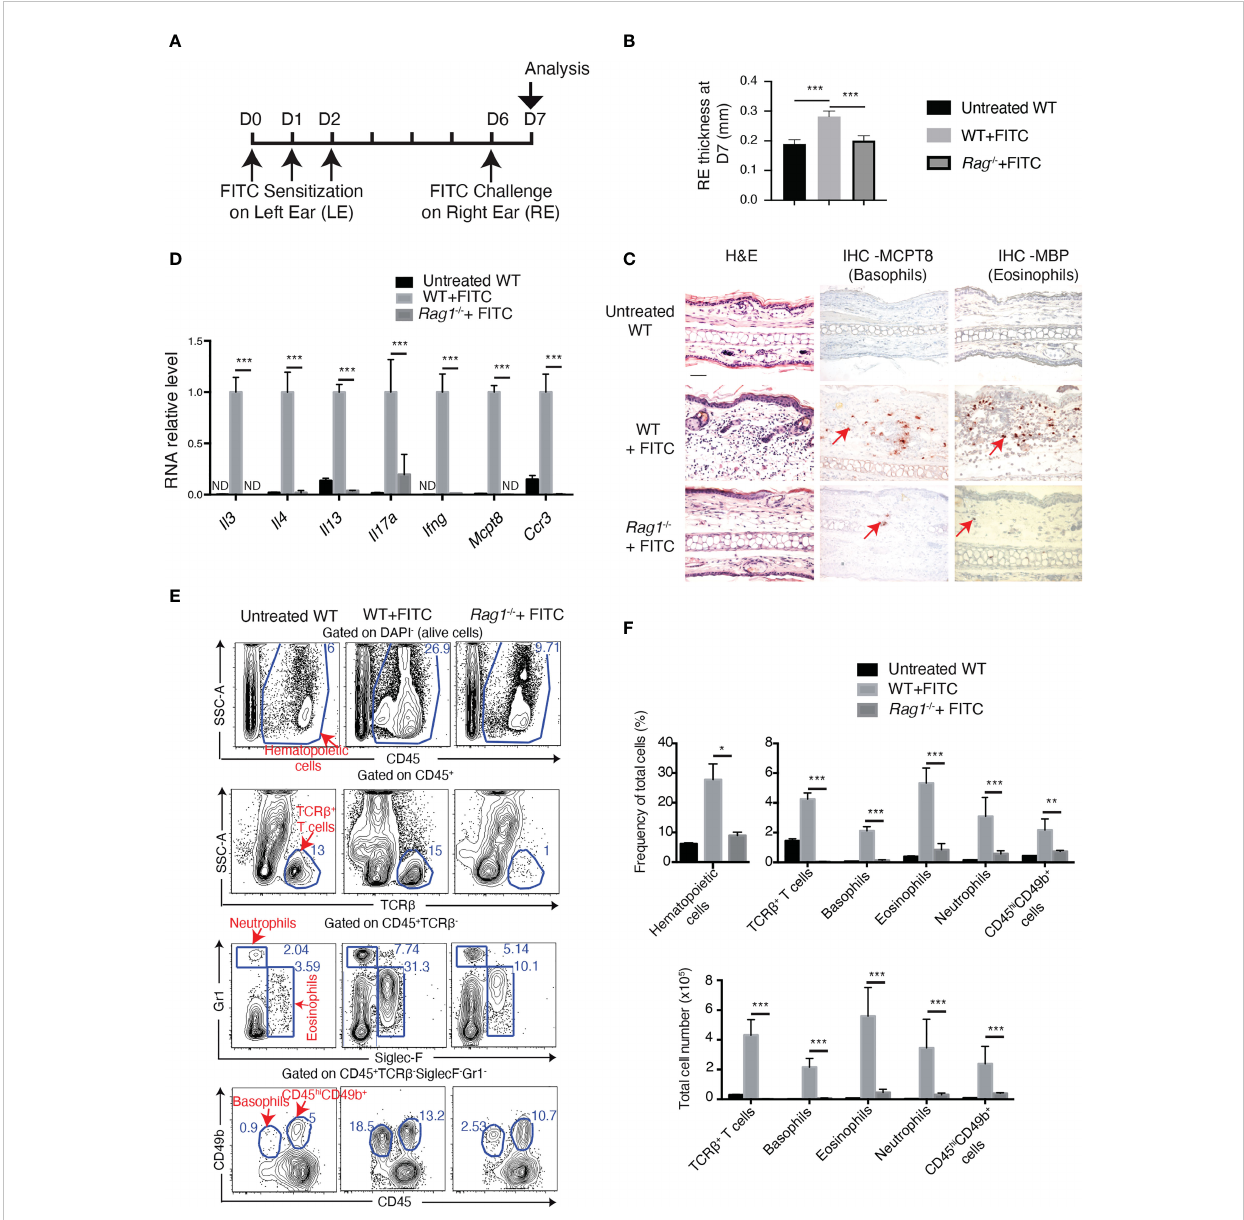
FIGURE 1 FITC treatment induces basophil accumulation in ACD skin in Rag1-dependent manner. (A) Experimental protocol. Eight to twelve-week-old female mice were sensitized with FITC on left ear (LE) at Day (D) 0, D1 and D2. Right ears (RE) were then challenged at D6 with FITC and sampled for analyses at D7. (B) RE thickness at D7. (C) Hematoxylin and eosin (H&E) and immunohistochemistry (IHC) staining of RE sections. Arrow points to one of the positive cells of IHC staining. Scale bar: 50 m m. (D) RT-qPCR analyses of cytokines in RE. ND, non-detected. (E) FACS analyses of dermal cells of RE for CD45 + (hematopoietic cells), CD45 + TCR b + T cells, CD45 + TCR b - Siglec-F + Gr1 low-neg (eosinophils), and CD45 + TCR b - Gr1 hi (neutrophils), CD45 low CD49b + Siglec-F - Gr1 - (basophils) and CD45 hi CD49b + Siglec-F - Gr1 - cells (which contain mast cells). (F) Comparison of frequency of total cells and total cel numbers. *P ≤ 0.05 **P ≤ 0.01, ***P ≤ 0.001 (Student's t-test). Values are mean ± SEM [ (B) , n=7; (D, F) , n=4 mice per